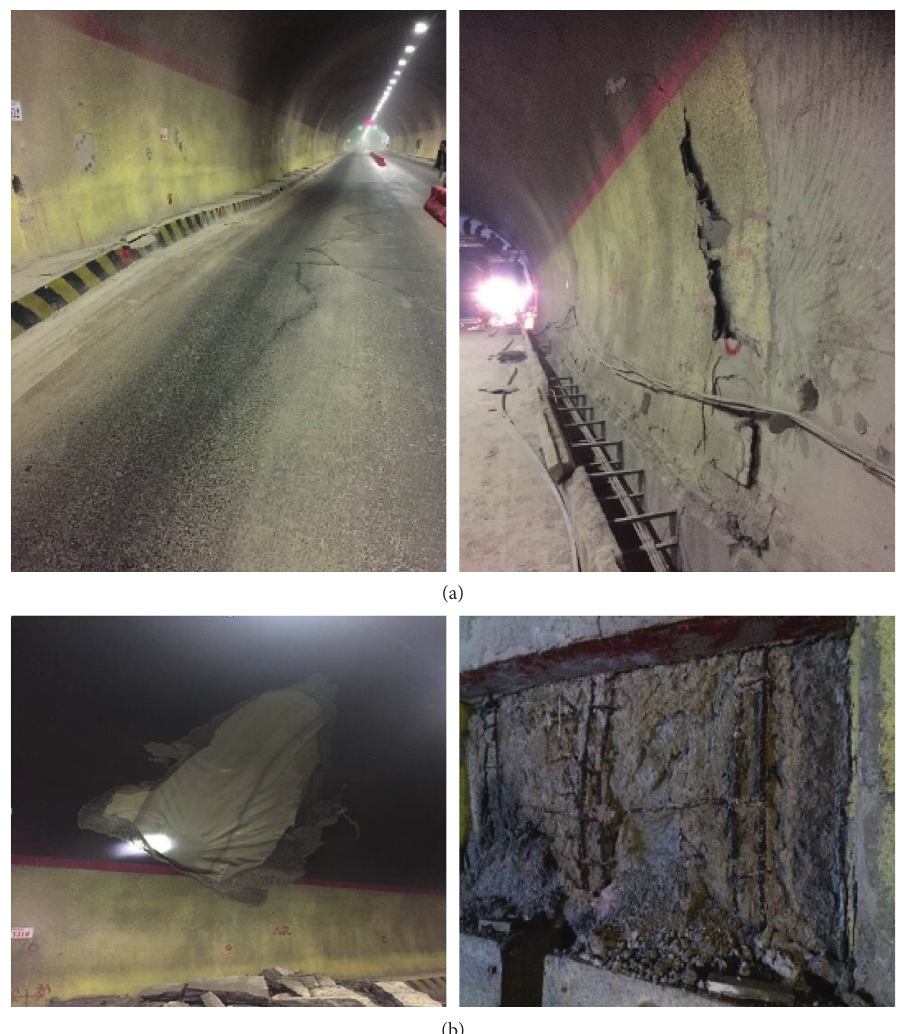
Figure 6: Photos of different damage degrees for Dugongling tunnel. (a) Initial damage of tunnel lining. (b) Further damage of tunnel